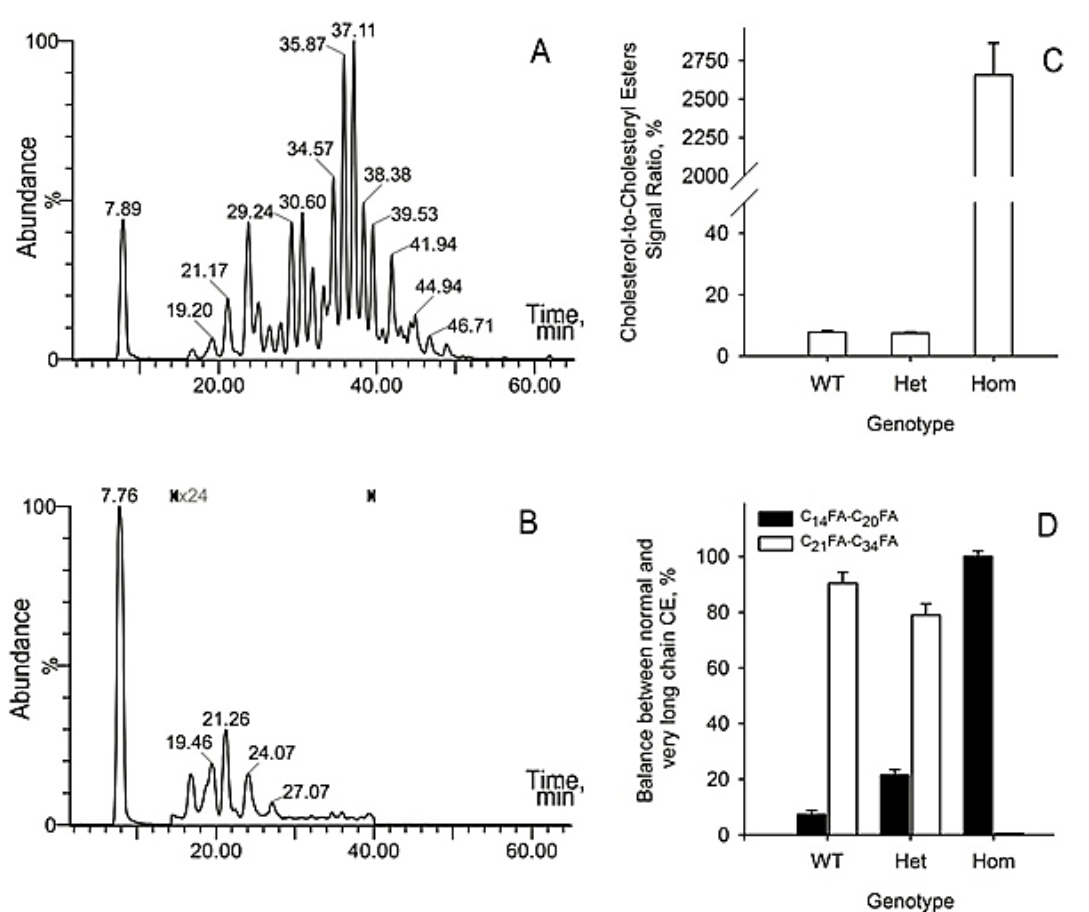
Figure 5. Inactivation of Soat1 causes suppression of the biosynthesis of long chain cholesteryl esters and accumulation of free cholesterol and short chain cholesteryl esters in meibum. Cholesterol and its esters in wild-type ( A ) and Soat1 -null ( B ) meibum. Note that the portion of the chromatogram between 14 and 40 min is magnified × 24 to make peaks visible on the graph (see black markings in the graph). Homozygous samples ( n = 5) were statistically different from heterozygous ones ( n = 7; p < 0.001). There were no statistically significant difference between heterozygous ( n = 7) and wild-type samples ( n = 5; p > 0.3). Effects of genotype on the cholesterol-to-cholesteryl esters ratios in meibum ( C ). Effects of Soat1 ablation on the elongation patterns of Meibomian cholesteryl esters ( D ). All samples were statistically different from each other ( p < 0.05). Note that formation of Chl-OAHFA was also severely inhibited. Results are shown as mean ± standard deviation values.